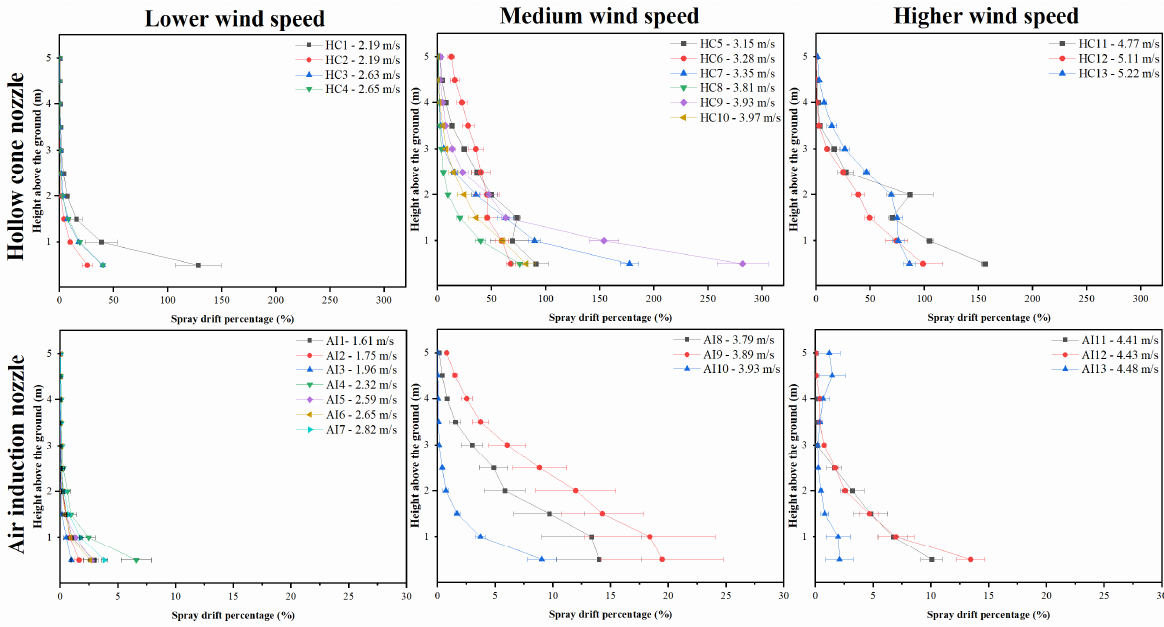
Figure 7. Airborne spray drift profiles obtained from the airborne drift collection frame using UASS with HC and AI nozzles at LWS, MWS, and HWS.